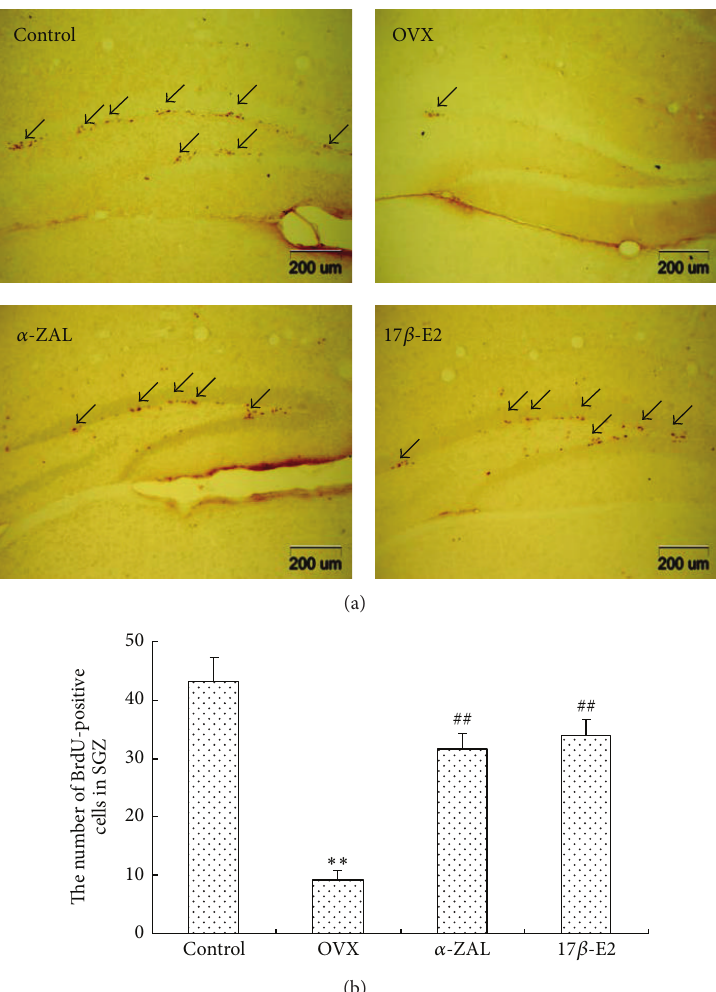
Figure 2: (a) Photomicrograph of 5-bromo-2-deoxyuridine (BrdU) immunopositive cells (new born neurons) in DG in the hippocampus of control and OVX mice with 17 𝛽 -E2 or 𝛼 -ZAL treatment. Fewer BrdU-labeled cells were observed in OVX mice compared to control. 17 𝛽 -E2 and 𝛼 -ZAL-treated mice expressed higher BrdU + cells compared to OVX animal. Magnification × 40. (b) Quantification of BrdU immunolabeling cells in DG. 𝑛 = 4 in each group and the result indicated at least three independent experiments in each animal. ∗∗ 𝑃 < 0.01 versus control group; ## 𝑃 < 0.01 versus OVX